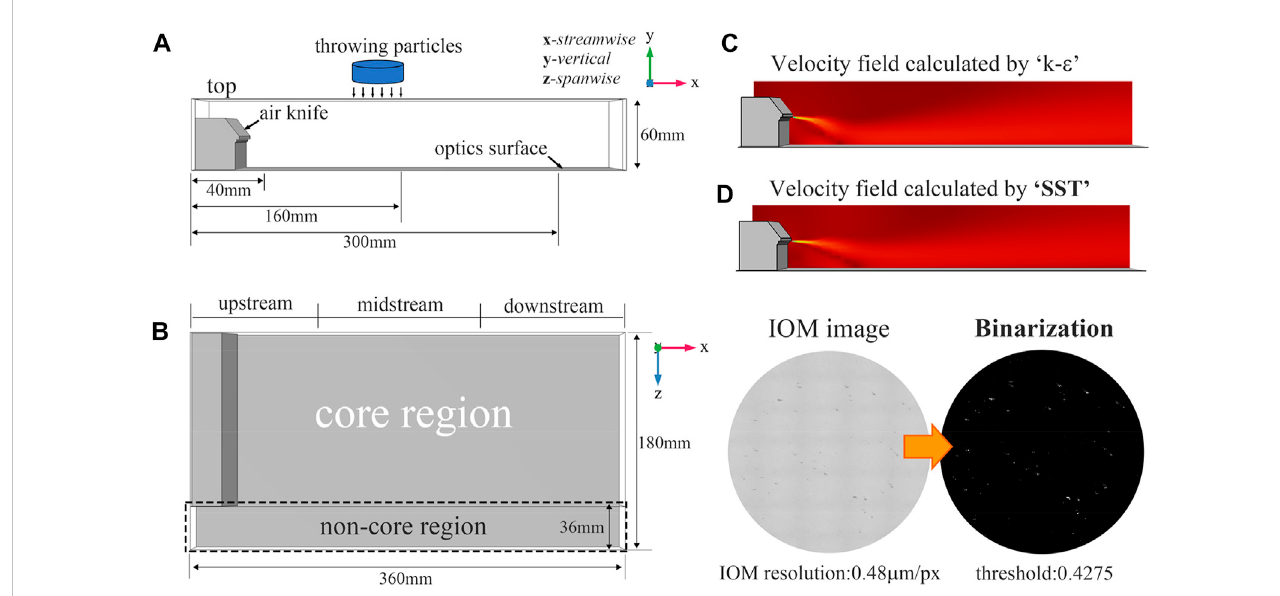
FIGURE 1 Establishmentoftheprotection fl owandarrangementonparticlethrowing. (A) frontviewprojectedinthexyplane, (B) topviewprojectedinthexzplane, (C) and (D) are the velocity distribution calculated by “ k- ε ” and SST turbulence model, respectively.